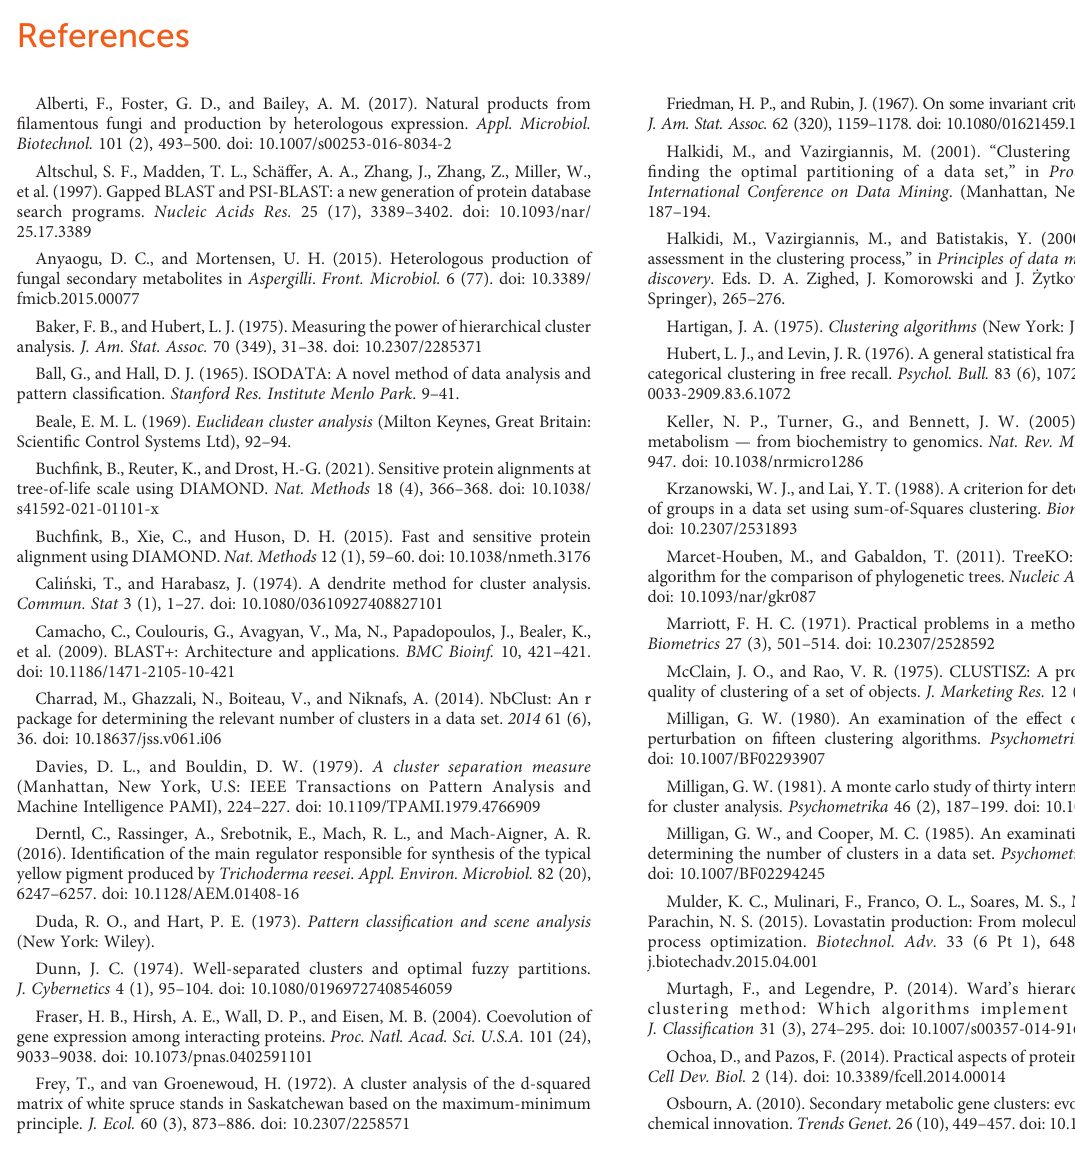
SUPPLEMENTARY TABLE 3 ResultsfortheanalysesofbenchmarkBGCsusingdifferentversionsofthe FunOrder